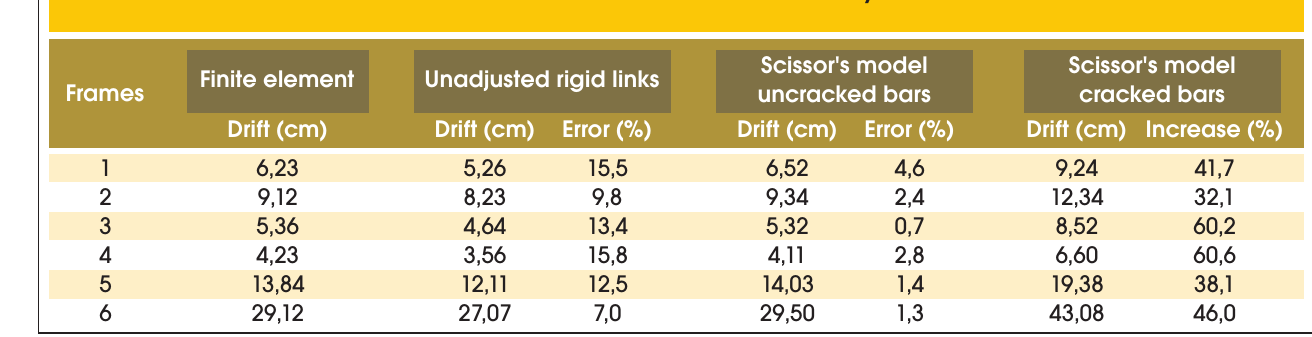
Table 5 – Results os second order